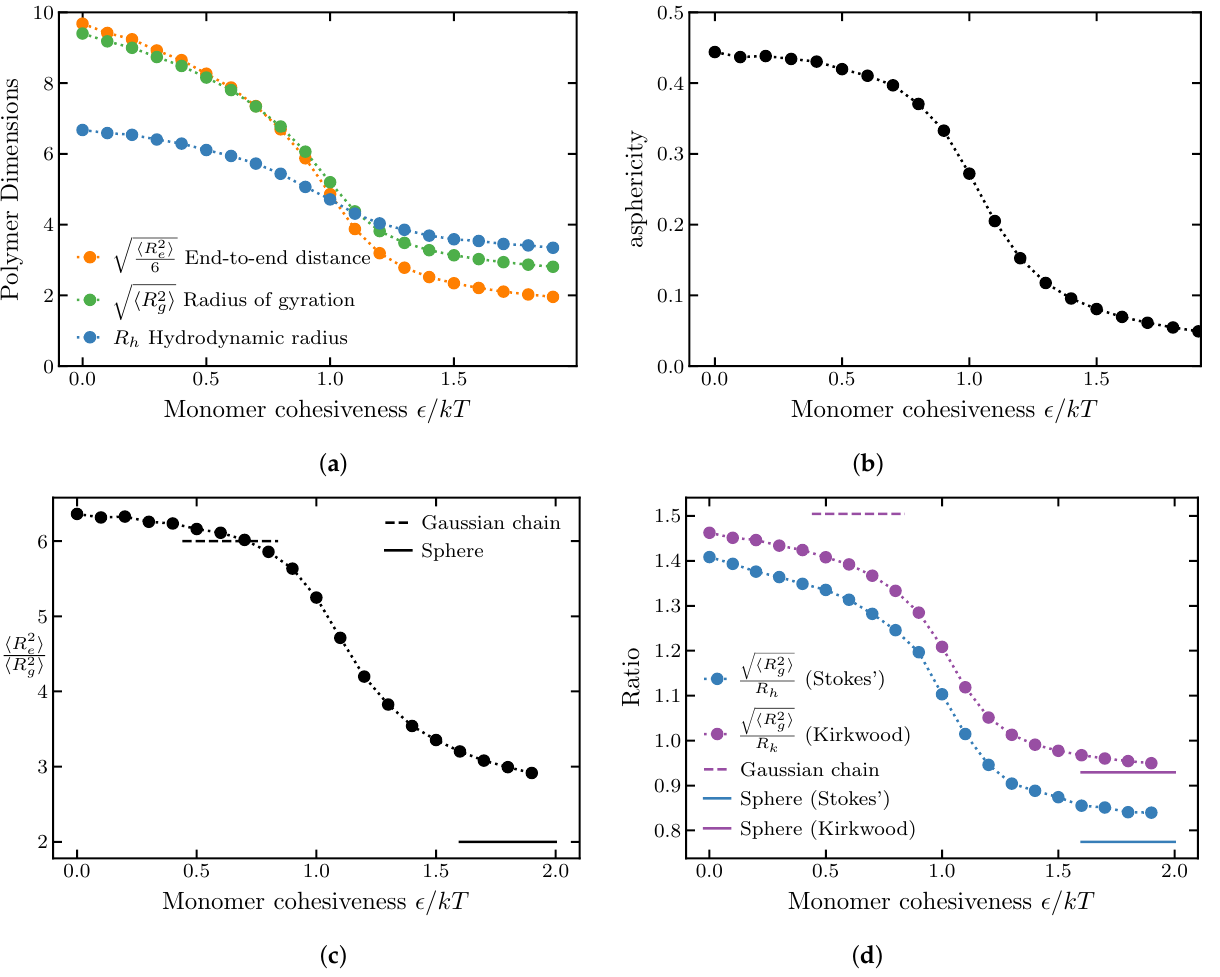
Figure 1. ( a ) Polymer dimensions of a homopolymer for varying monomer cohesiveness. ( b ) As- phericity of a homopolymer for varying monomer cohesiveness. ( c ) Ratio of the square of the end-to-end distance to the square of the radius of gyration of a homopolymer for varying monomer cohesiveness. The dashed lines correspond to the Gaussian chain predictions; the solid lines corre- spond to a uniform sphere. The ratio of square of the end-to-end distance to the square of the radius of gyration agrees with the Gaussian chain prediction ( R 2 e / R 2 g = 6) at the θ point ( (cid:101) 0.7 0.75 kT). ≈ − ( d ) Blue: ratio of the radius of gyration to the hydrodynamic radius. Purple: ratio of the radius of gyration to the Kirkwood approximation to the hydrodynamic radius. The good solvent corresponds to (cid:101) = 0, the θ solvent corresponds to (cid:101) 0.7 0.75 kT and poor solvents correspond to (cid:101) > 1.5 kT. ≈ − The number of monomers is N =